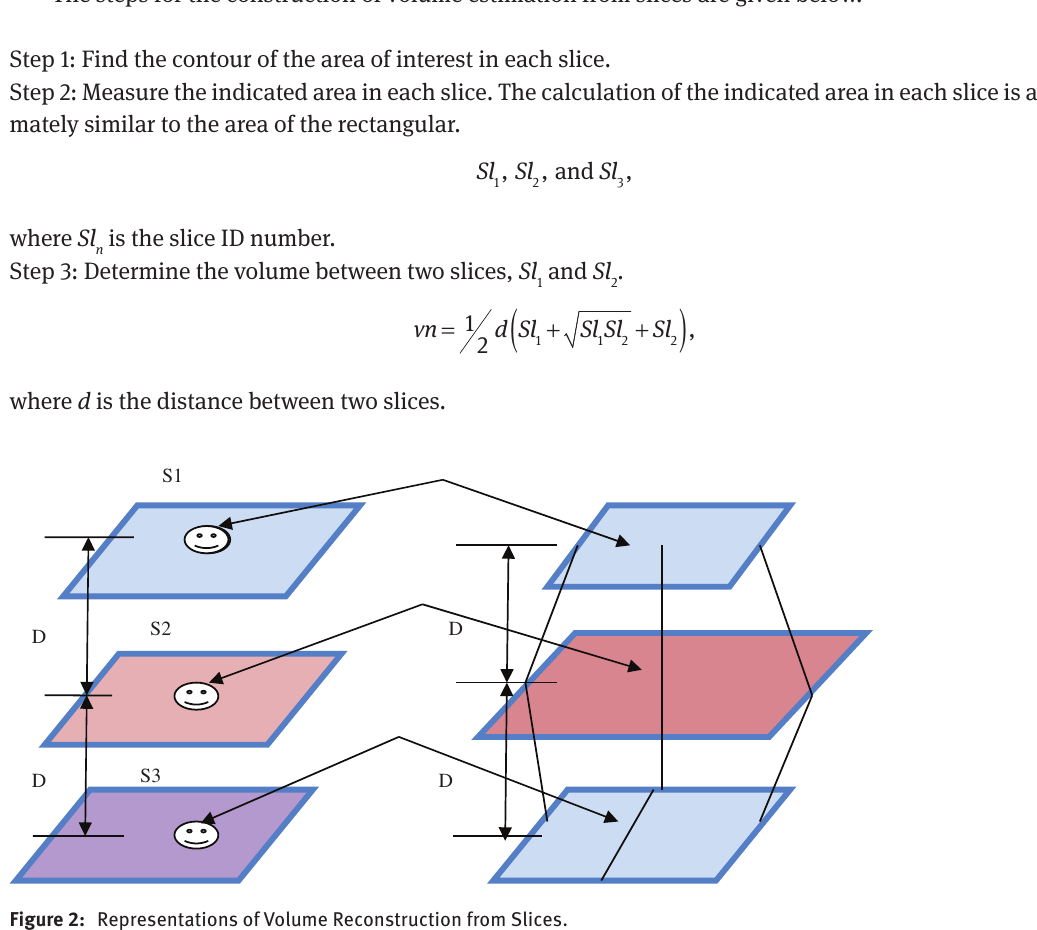
Figure 2: Representations of Volume Reconstruction from